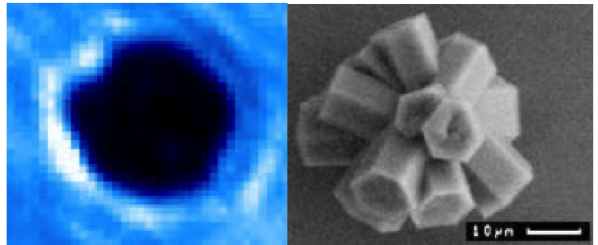
Fig.3. Asmalliceanalogue( D =48 µm)imagedbyaCPI(left)andbyascanningelectronmicroscope(right) Fig. 3. A small ice analogue ( D = 48µm) imaged by a CPI (left) with 10µm scale bar. Adapted from Ulanowski et al. (2004). and by a scanning electron microscope (right) with 10µm scale bar. Adapted from Ulanowski et al.